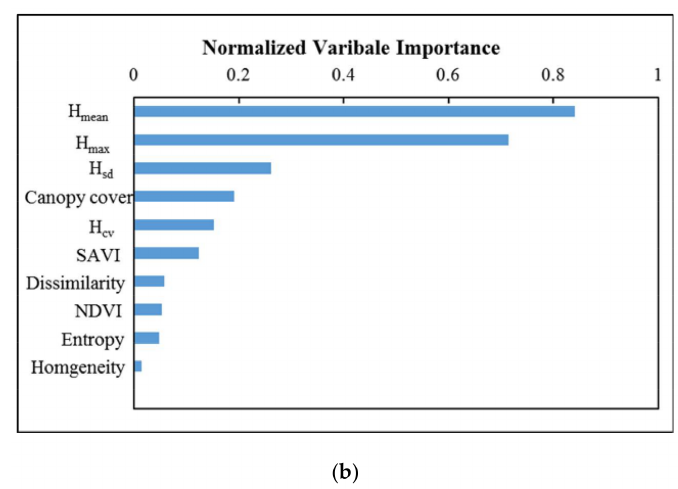
Figure 5. ( a ) Map of the mean biomass estimates as obtained from the 50 bootstrapped model runs, using the LiDAR and optical data variables in the random forest model; ( b ) the important contributions of different predictor variables were used in the estimation.